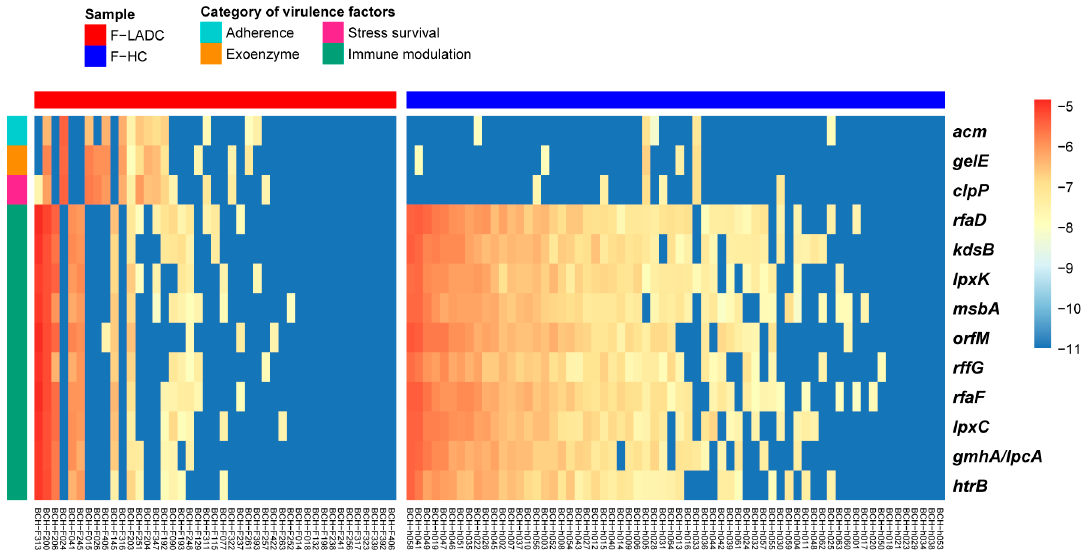
Figure 7. Heatmap of virulence factors with the most differences in abundance from LEfSe analysis. LefSe analysis was performed with p < 0.05 and LDA score > 2.5 for the relative abundance of virulence factors. Blue represents lower abundance and red represents higher abundance. The bar at the top indicates sample groups, with red and blue representing patients with LADC (n = 43) and healthy controls (n = 64), respectively. The bar on the left side of the heatmap indicates the category of virulence factors.